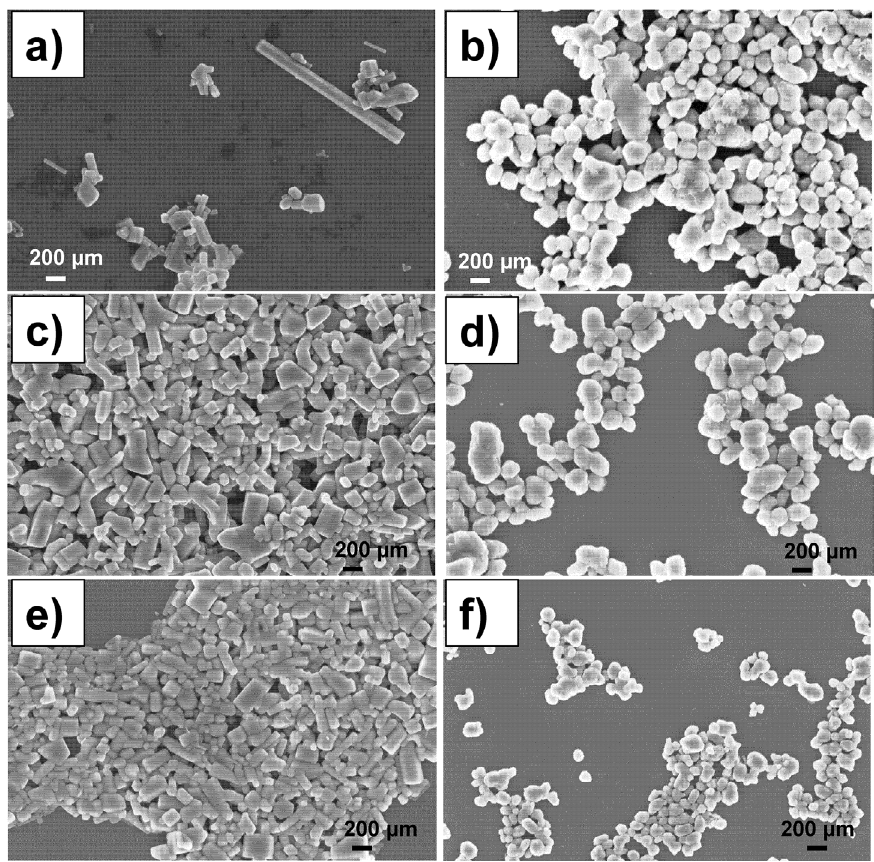
before (a-b) and after sonication processes for 5 minutes 2